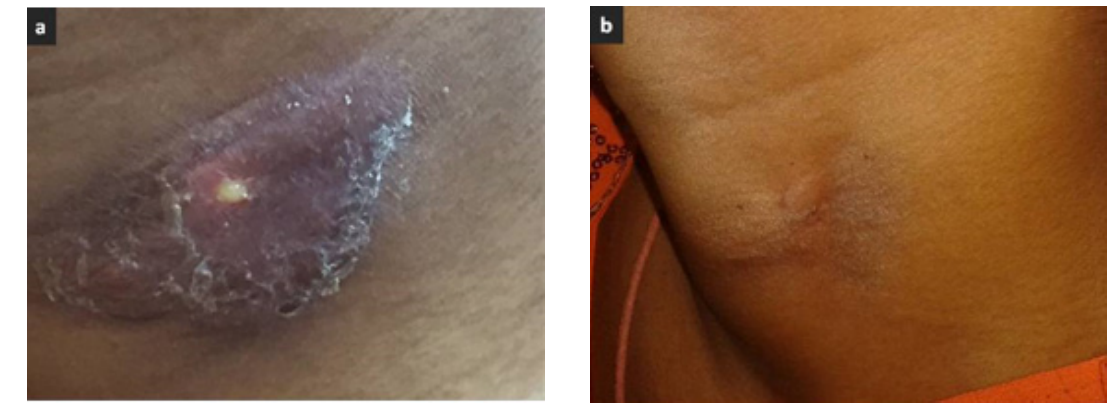
Figure 3. Patient with cervical abscess due to melioidosis on ( a ) initial presentation and ( b ) four months after ceftazidime therapy.